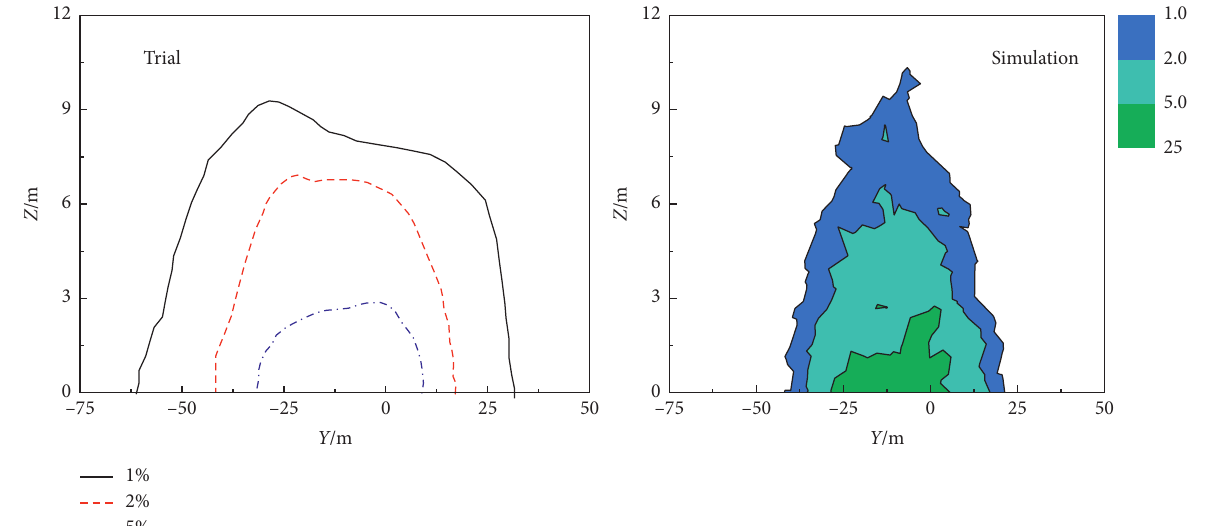
Figure 6: Comparison of Burro 9 trial and Fluent simulation for LNG vertical volume-concentration distribution ( X � 140m and t � 80 s).